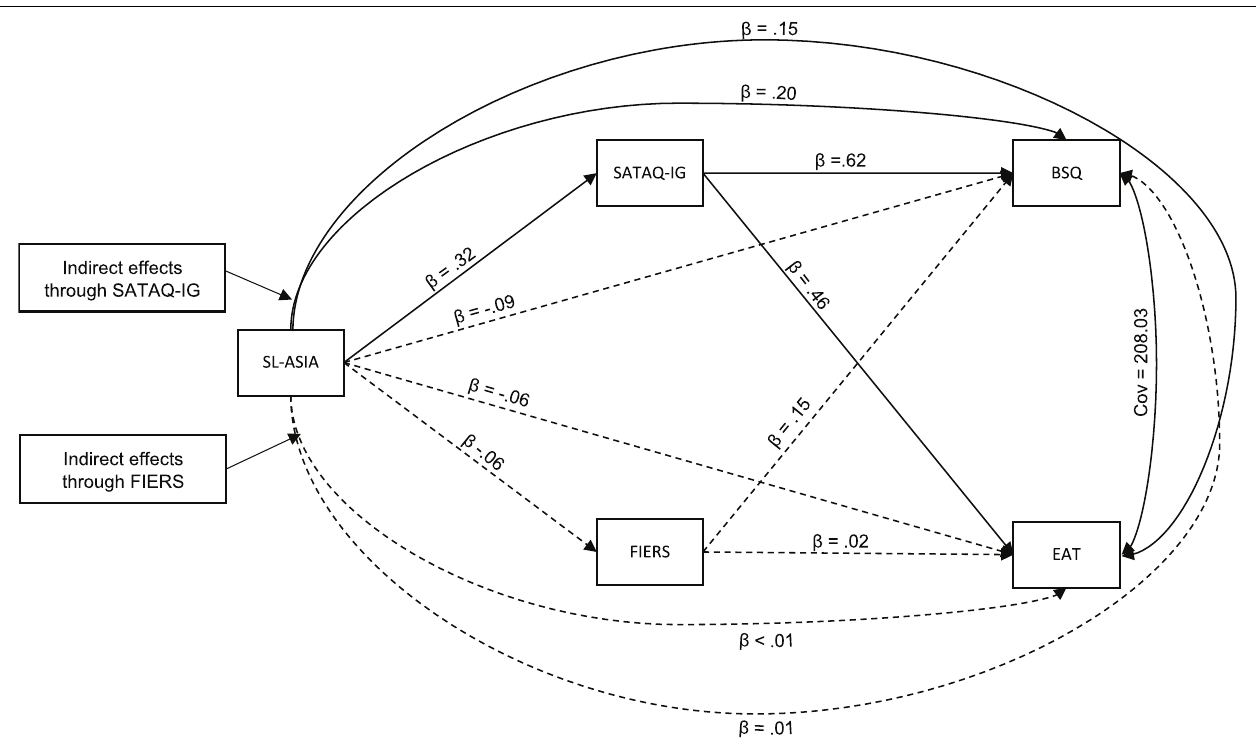
FIGURE 1 | Model used in the SEM analyses. Straight lines indicate direct paths; curved single-arrow lines indicate indirect paths; solid lines indicate a significant path ( p < 0.05); dashed lines indicate non-significant paths ( p > 0.05) based on unstandardized coefficients. Standardized coefficients for direct effects ( β ) are presented. SL-ASIA, Suinn-Lew Asian Self-Identify Acculturation Scale; SATAQ-IG, Sociocultural Attitudes Toward Appearance Questionnaire-Internalization General subscale; FIERS, Feagin Intrinsic-Extrinsic Religiosity Scale; BSQ, Body Shape Questionnaire; EAT, Eating Attitudes Test. Note that paths for BMI and US-Born are not